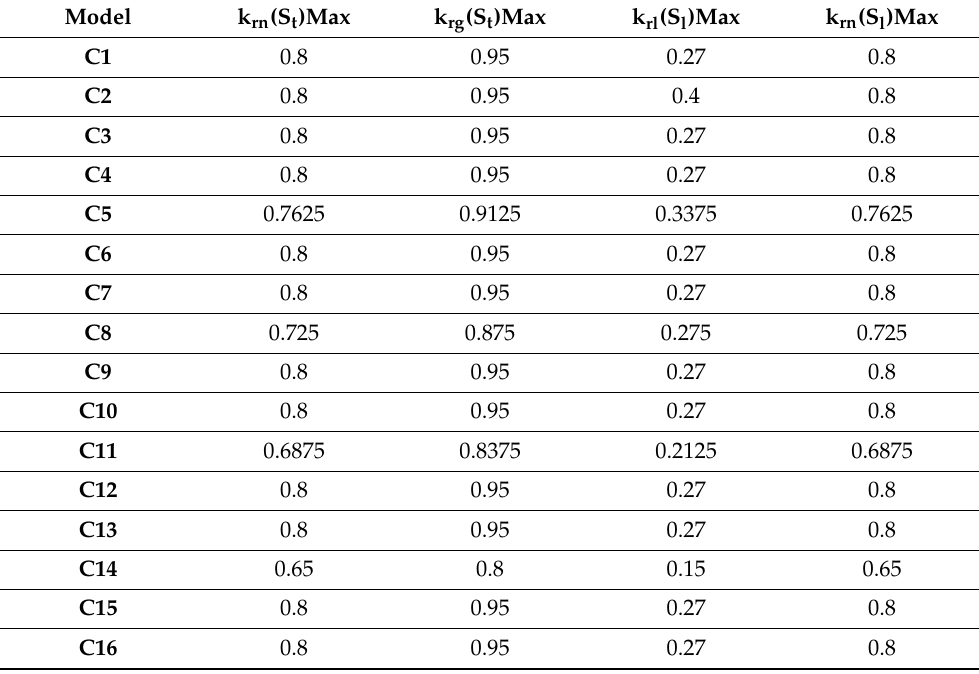
Table 2. Maximum relative permeability values used in Equations (1)–(4) to create the relative permeability curves used in this